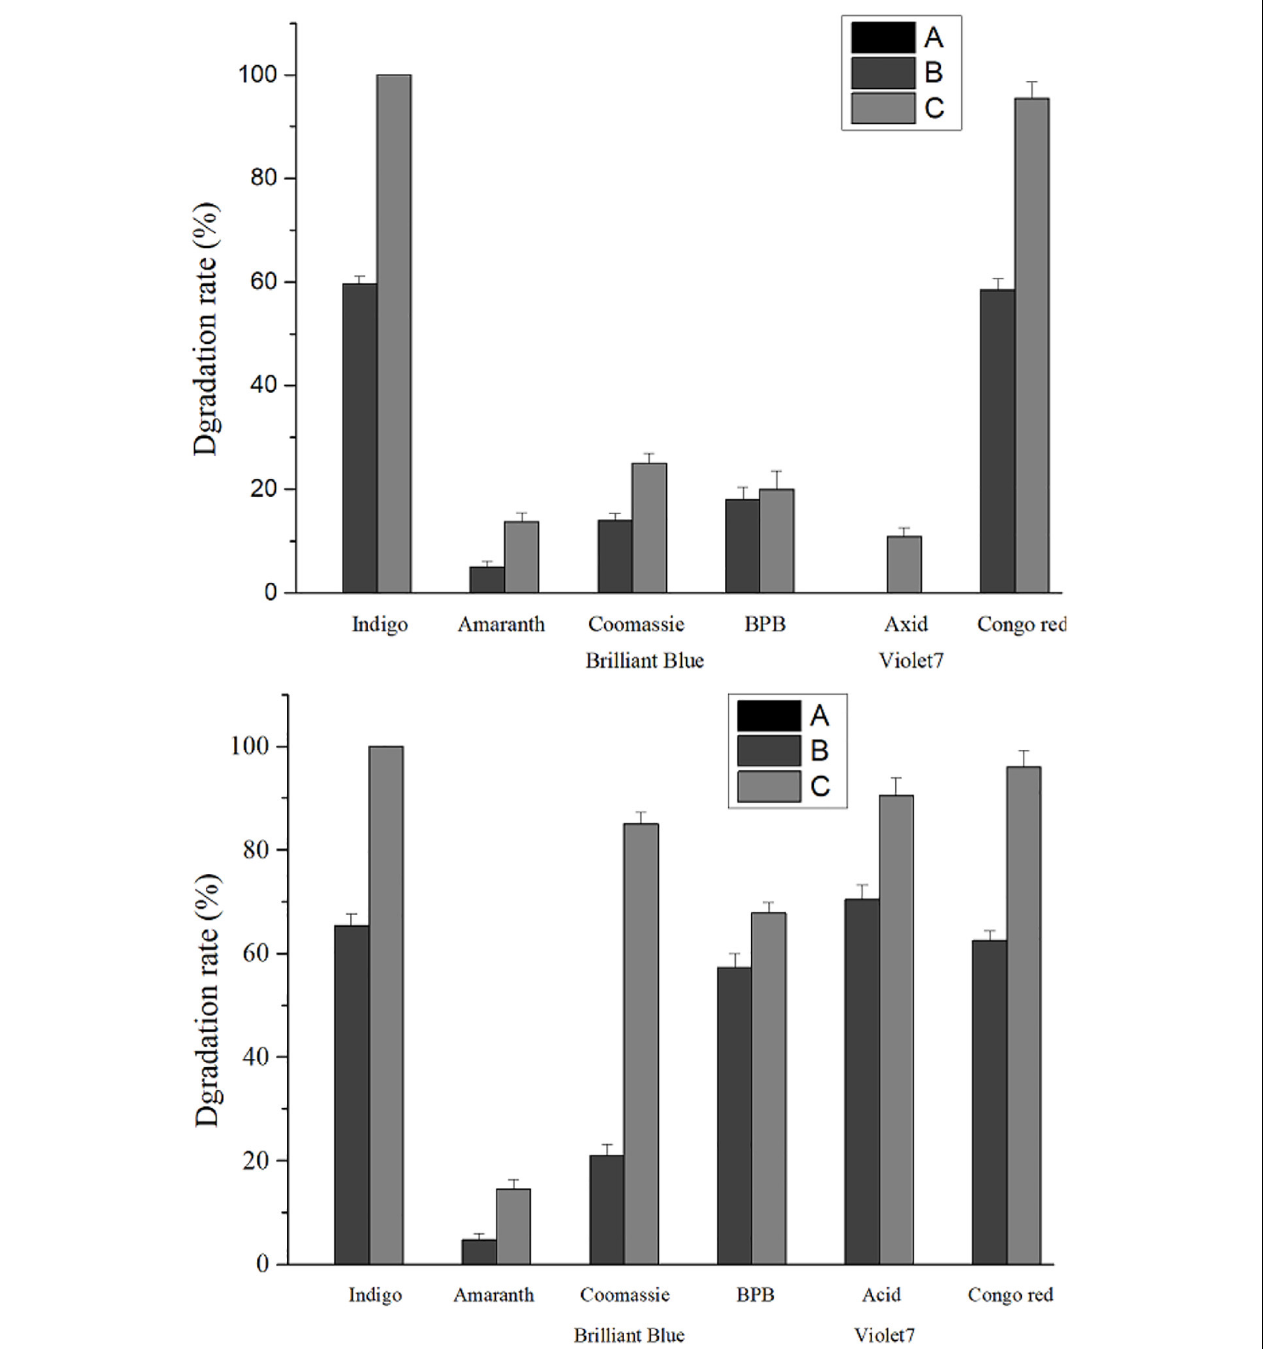
FIGURE 4 | Comparison of dye degradation rate between mutant enzyme lac2-9 and rlac1338 in the presence of small molecule mediator ABTS and Ca 2 + . A, no ABTS and Ca 2 + ; B, 100 mM Ca 2 + ; C, 100 mM Ca 2 + and 20 µ M ABTS. Measurement conditions: 37 ◦ C, decolorization for 24 h.